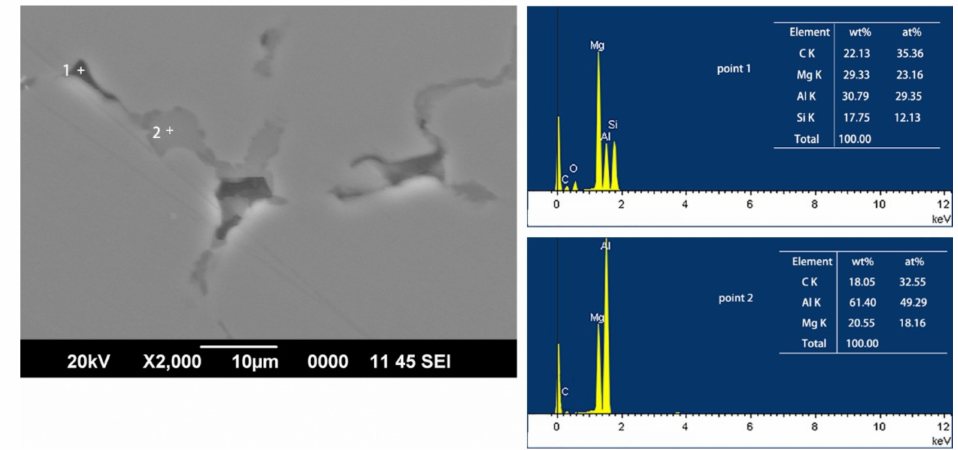
Figure 3. Energy dispersive spectroscope (EDS) results of point 1 and point 2 in the as-cast 2.5Li